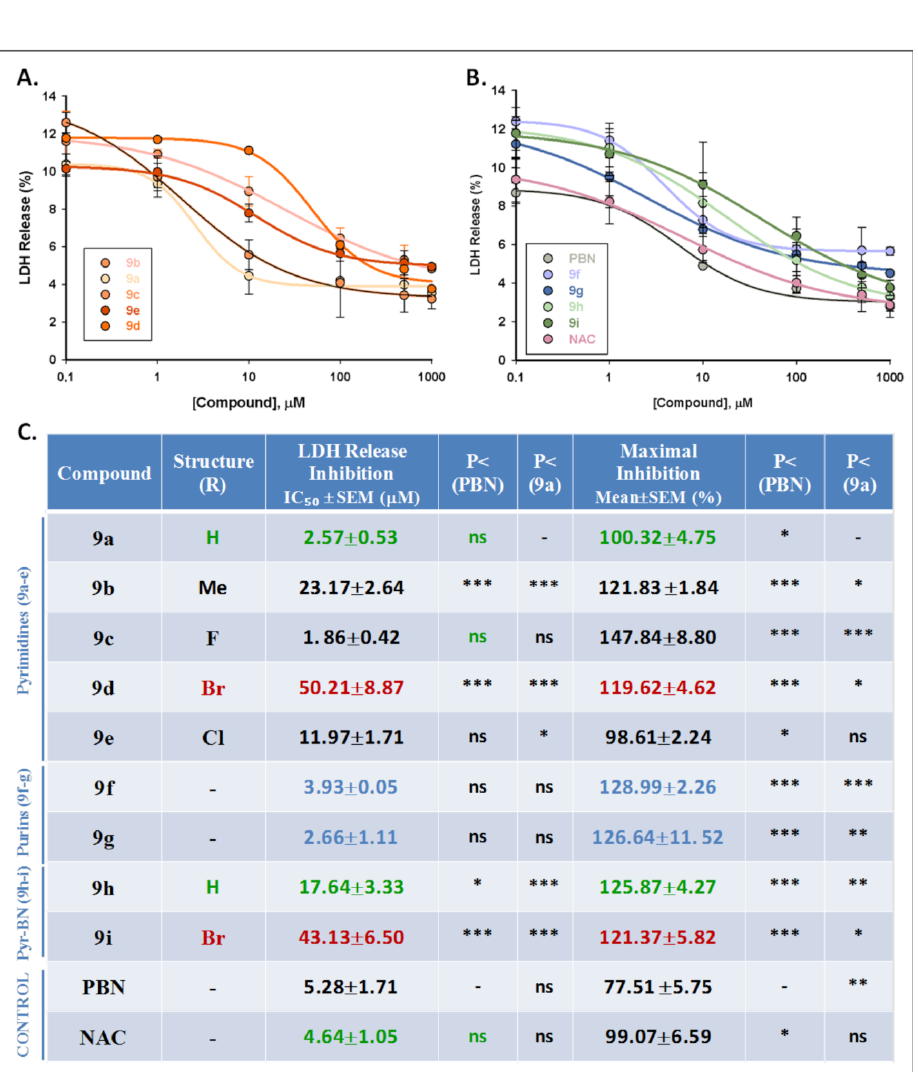
Figure 6. Neuroprotective effects of nitrones 9a – i , PBN , and NAC against necrotic cell death in- duced by IR treatment in SHSY5Y cells. ( A , B ) Concentration-response curves showing the percent antinecrotic effect of different compounds (nitrones 9a–e ( A ) and nitrones 9f–i, PBN and NAC ( B )) at the specified concentrations. ( C ) IC 50 and Maximal Activity data for the indicated compounds Data representation, curve fitting, and statistical analysis of the data was performed as shown in Figure 4. Statistical differences were performed vs. PBN , or nitrone 9a at * p < 0.05, ** p < 0.01 y *** p <